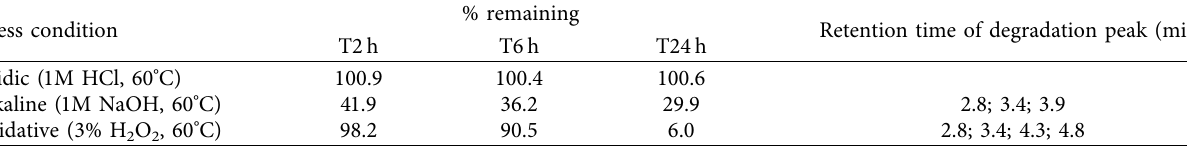
Table 1: Remaining concentration of ruxolitinib phosphate and retention time of degradation products detected.